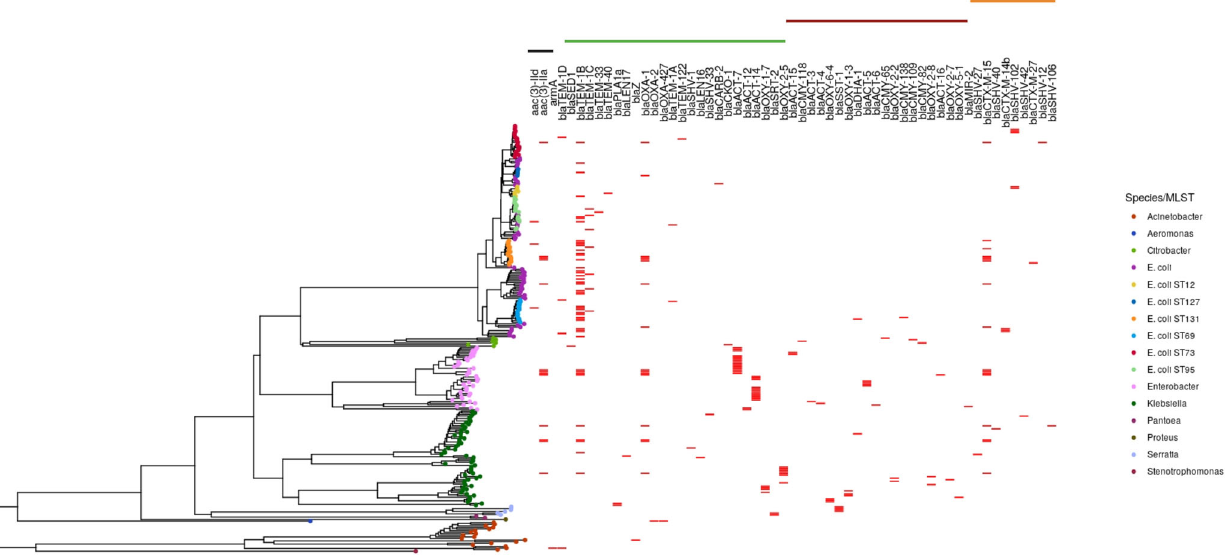
Fig. 3 Carriage of antimicrobial resistance genes by isolates sequenced in the study. The tree was created using mashtree and gene presence is shown in red. The black/green/maroon/orange bars at the top represent the carriage of genes producing enzymes with activity (as predicted by Res fi nder) against aminoglycosides/amoxicillin/cefotaxime ( + amoxicillin)/ceftriaxone ( + cefotaxime/amoxicillin)